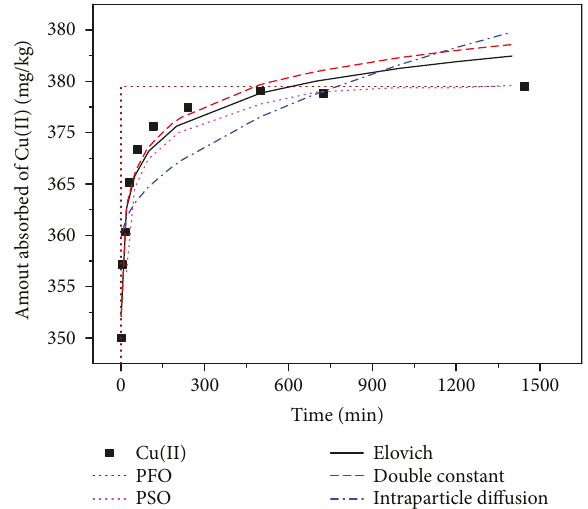
Figure 1: Kinetic adsorption models of Cu(II) on soil (conditions: pH 5.5, 60-mesh sieve particle size, 1g adsorbent dosage, 180 rpm, and 25 °